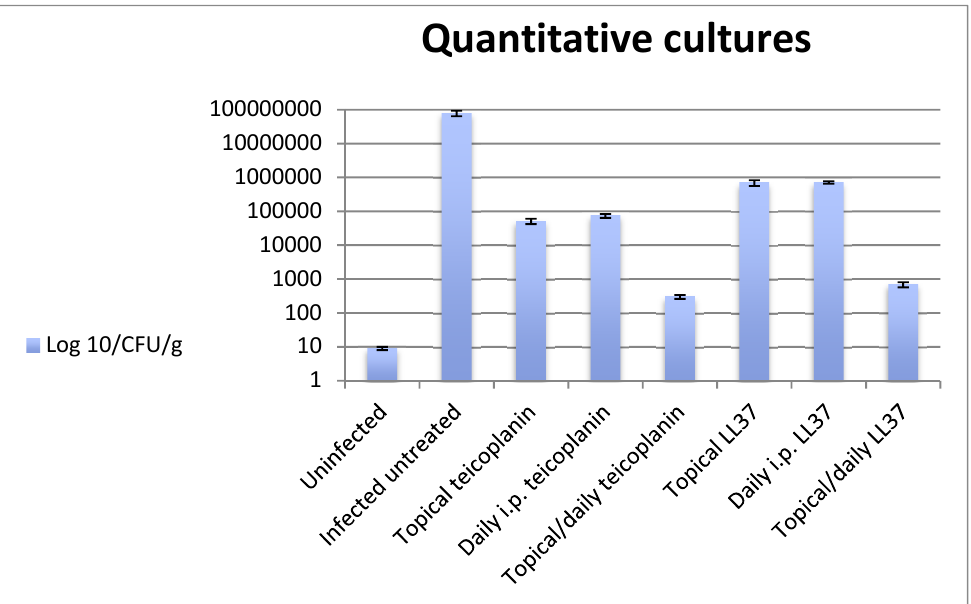
Figure 1. Bacterial growth in untreated and treated animals.